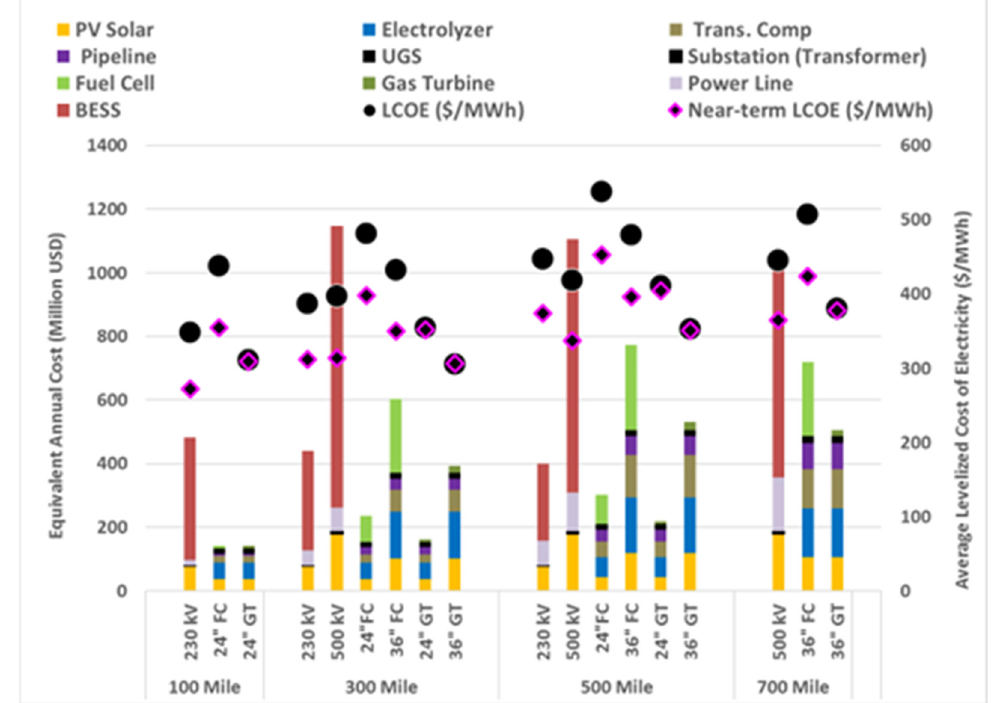
Figure 4. Equivalent annual cost breakdown and levelized cost of electricity. Scenario is for constant transmission utilization factor scenario in which the all-electric pathway only meets 95% of load and hydrogen pathways meet 100% of load.